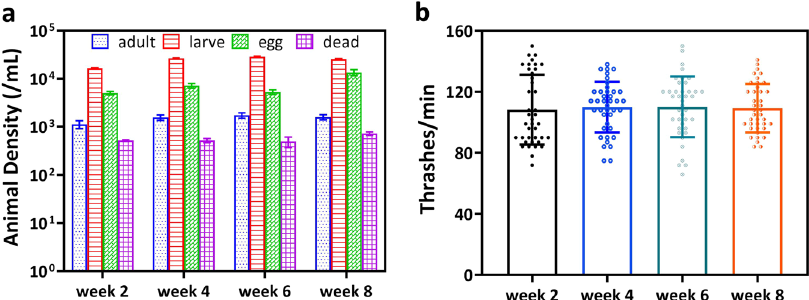
Fig. 2 Characterization of culture growth and health across the eight-week multi-generational experiment. a Characterization of the culture density including adults, larvae, eggs, and dead animals. b Swim-induced thrashing frequency of gravid adults as a measure of their locomotory health (Supplementary Table 1). Error bars represent standard deviation. All the data pass the normality test. There is no signi fi cant difference between thrashing frequency as calculated by one-way ANOVA, P ≥